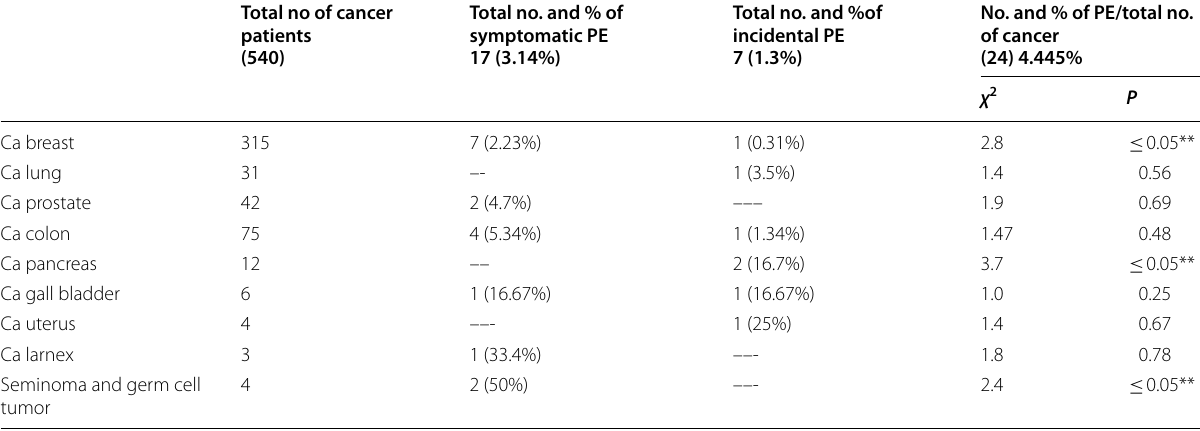
PE pulmonary embolism, Ca cancer, no number